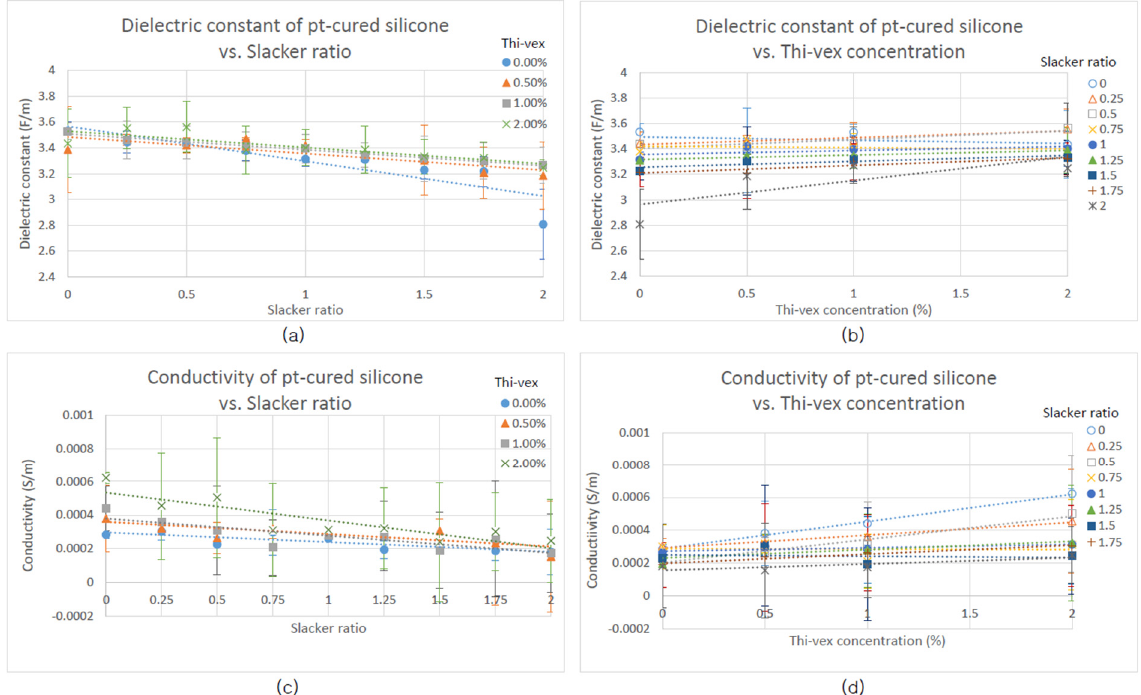
Figure 1. Dielectric properties of platinum-cured silicone samples relative to Slacker and Thi-vex concentrations. ( a ) Dielectric constant of platinum-cured silicone with various Thi-vex concentrations relative to Slacker ratio. ( b ) Dielectric constant of platinum-cured silicone at various Slacker ratios relative to Thi-vex concentrations. ( c ) Conductivity of platinum-cured silicone with various Thi-vex concentrations relative to Slacker ratio. ( d ) Conductivity of platinum-cured silicone at various silicone:Slacker ratios relative to Thi-vex concentration.